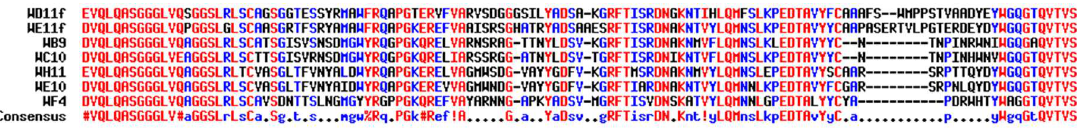
Figure 1. Deduced protein sequences of the seven single-domain antibodies (sdAb) that were evaluated. Sequences are given in single letter amino acid code. Alignment was performed using Multalin; high homology positions are shown in red, where lower homology is in blue [48]. Each of the selected sequences was then cloned into an expression vector (pET22b) and produced via E. coli in 0.5 liter-scale shake flasks and purified. Protein yields are shown in Table 1. The majority of produced protein was monomeric with very little potential aggregation observed; a typical FPLC chromatogram is shown in Appendix Figure A1. With the exception of WF4, all produced more than